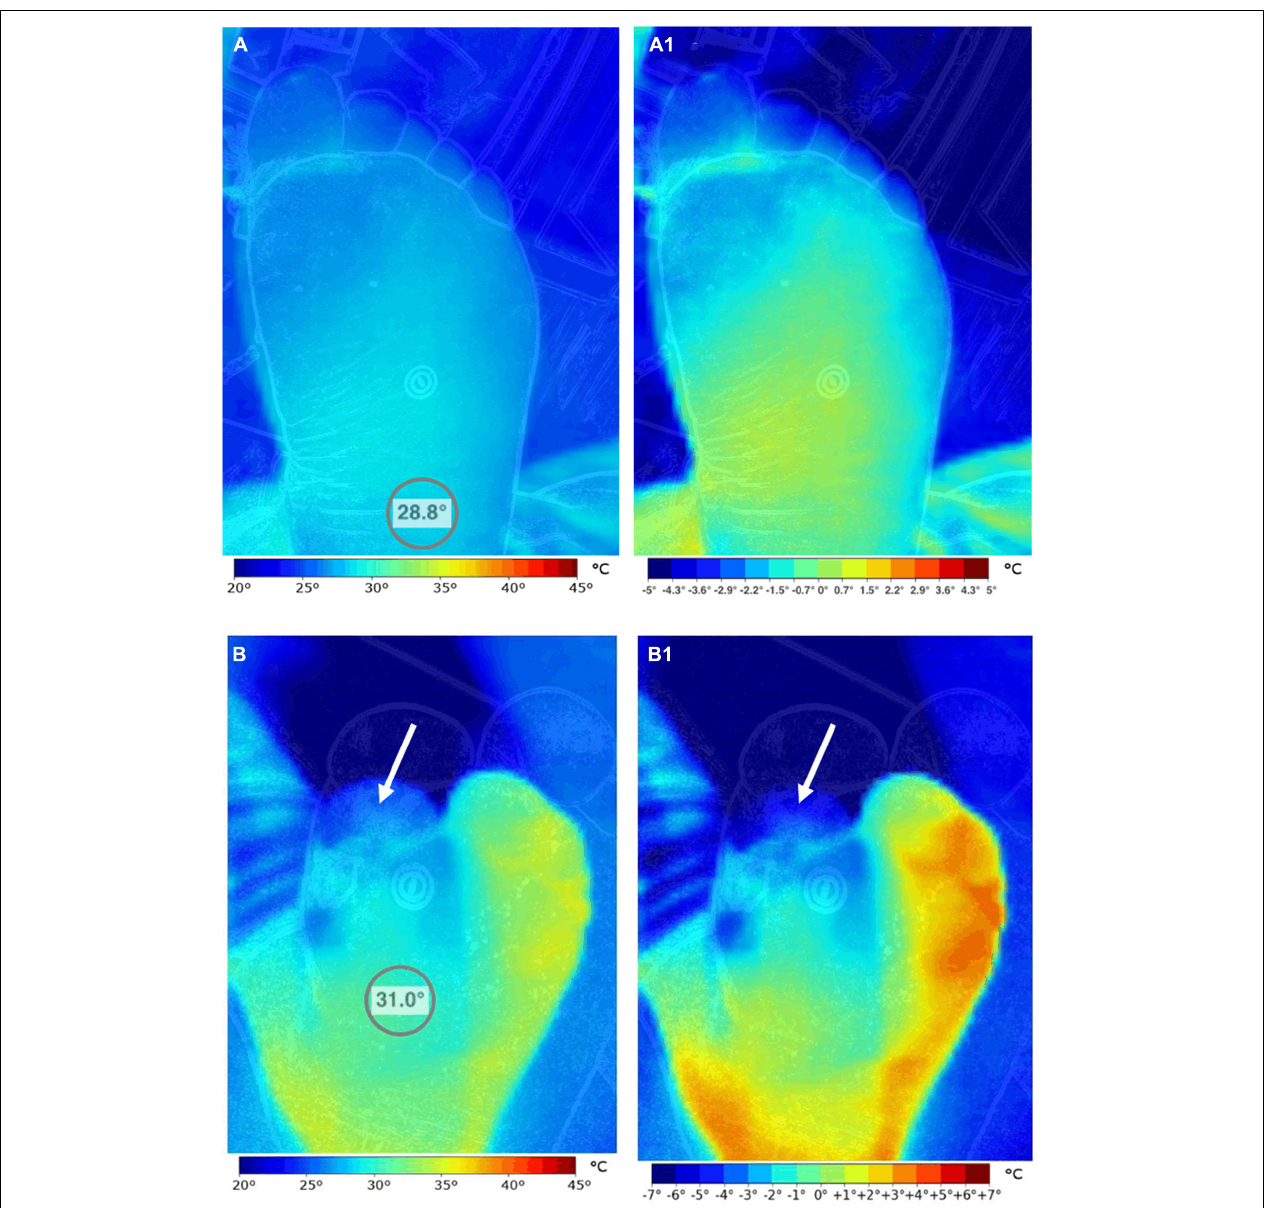
FIGURE 3 | Comparison of the thermographic pattern of two subjects with and without diabetes. The left foot of a healthy subject (A,A1) and a patient with diabetes mellitus and vascular complications (B,B1) were imaged. Striking differences in the absolute temperature distribution pattern of the foot (A,B) can be observed. These differences are magnified when the images are scaled to present temperature gradients (A1,B1) . While the healthy control presents a more or less uniform temperature pattern in the hind and mid-foot, the patient with diabetes shows extensive temperature variability that is correlated to microangiopathy and neuropathy. Note that the first toe of the diabetes patient and its medial side show signs of significant vascular compromise (arrows). Images, courtesy of JR-G, were acquired using the Skin and Wound mobile app paired to a Swift Vision camera (Swift Medical Inc., Toronto, ON,